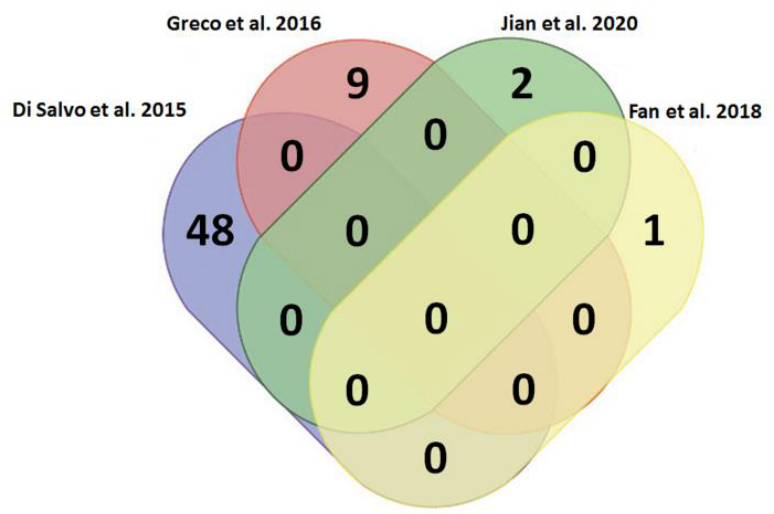
Figure 3. Venn diagram for the analysis of commonly deregulated lncRNAs related to heart failure